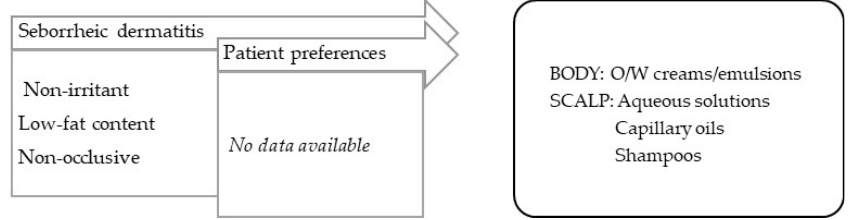
Figure 5. TPP for formulations for treatment of seborrheic dermatitis and most suitable vehicles/bases.